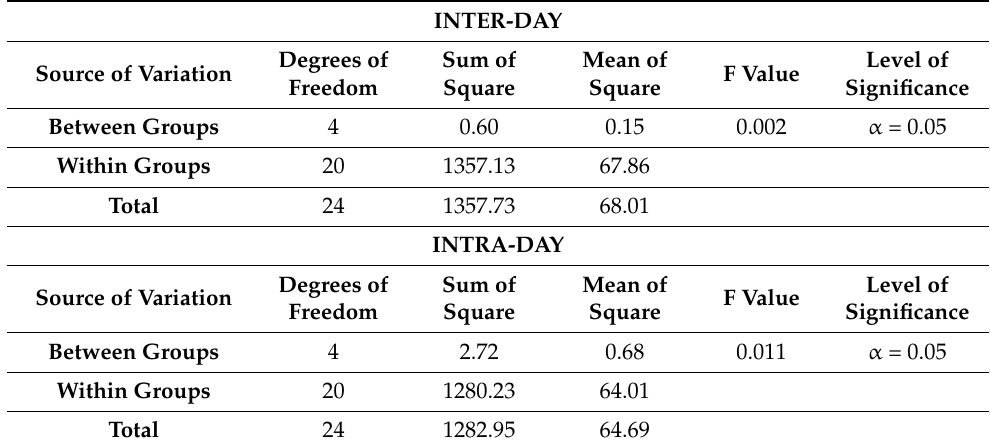
Table 2. Results of the one-way ANOVA test for the inter- and intra-day precision and trueness data.